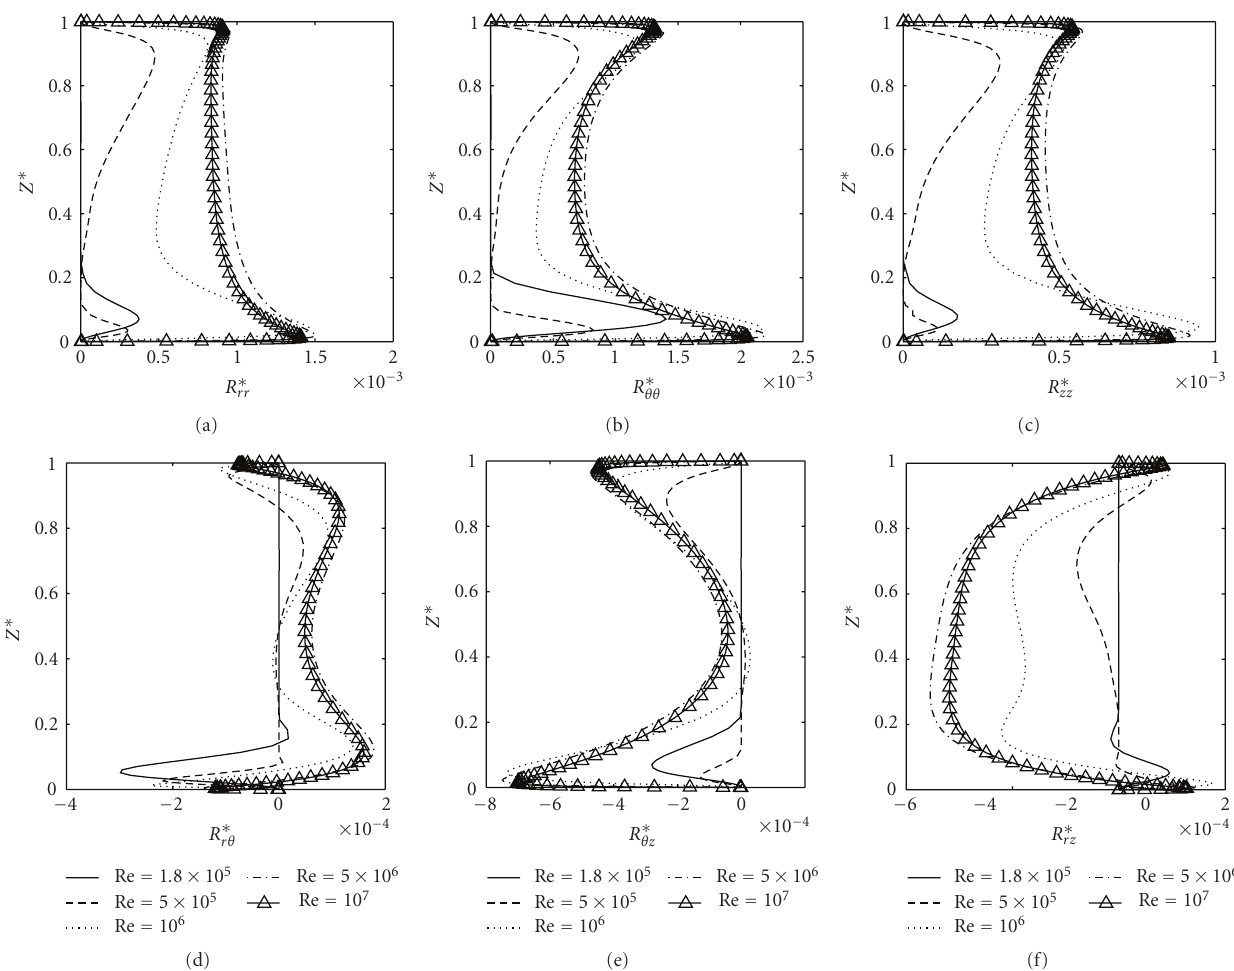
Figure 11: Axial profiles of the six Reynolds stress tensor components at r ∗ = 0 . 57 for G = 0 . 02 and di ff erent Reynolds